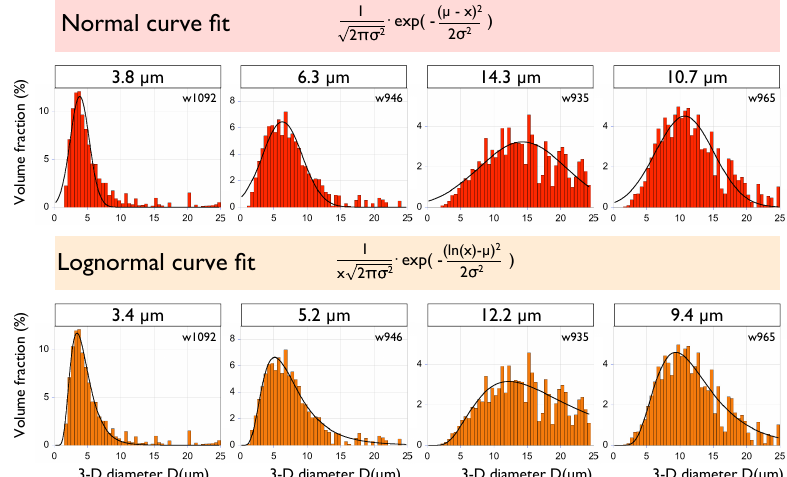
Figure A2. Deriving modal grain size. Volume-weighted histograms v(D) are shown for four high-strain samples of regimes 1, 2, and 3. To derive the modal value, a normal (Gaussian) and a lognormal curve fit are used. The derived modal values are